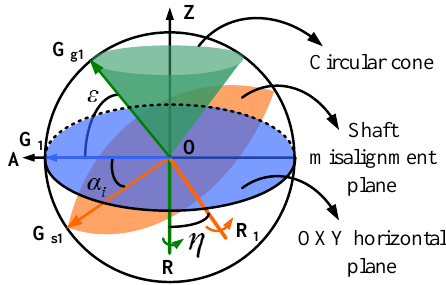
Figure 4. The gyro axis’s trajectory with the gyro misalignment or the shaft misalignment when the shaft is rotated counterclockwise around itself for 360 ◦ (the sphere is not the earth, but is used to facilitate understanding of the